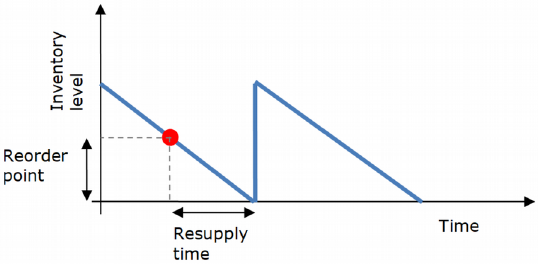
Figure 1. Reorder point (Wanke,